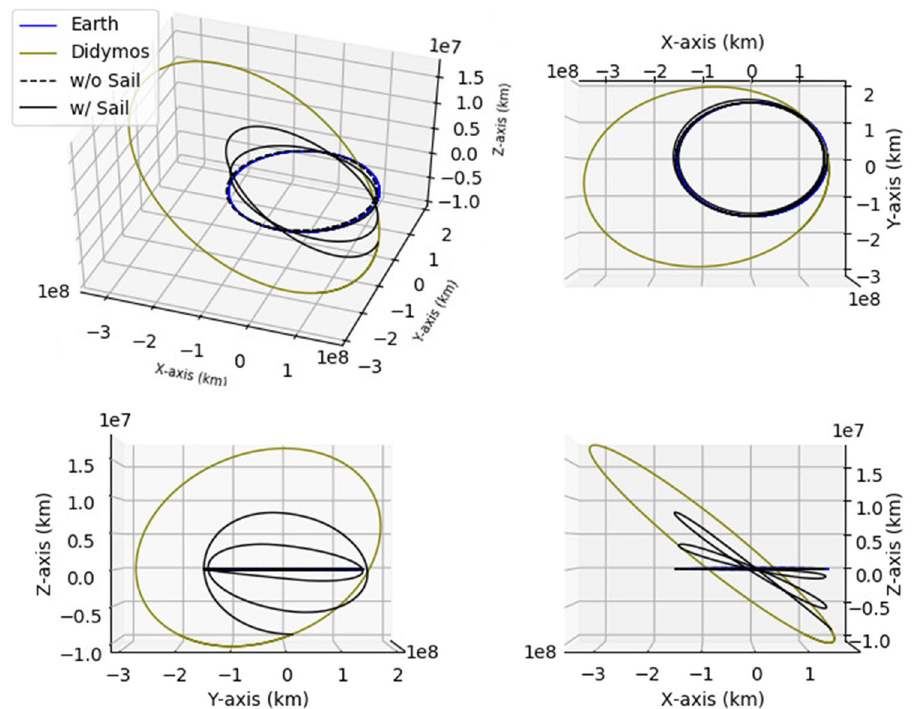
Figure 13. Didymos interception for a tof of 855 days and sail loading of 164.7 g / m 2